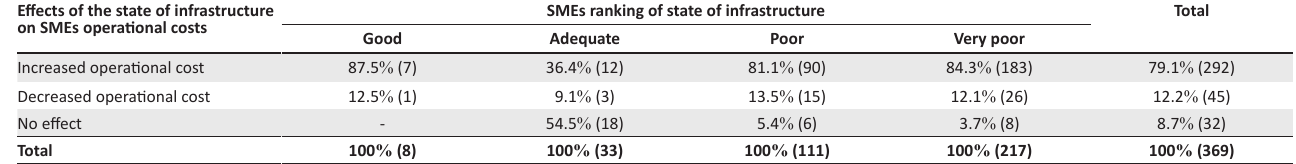
TABLE 2: Showing the cross-tabulation of SMEs ranking of the state of infrastructure and operating cost. Effects of the state of infrastructure on SMEs operational costs